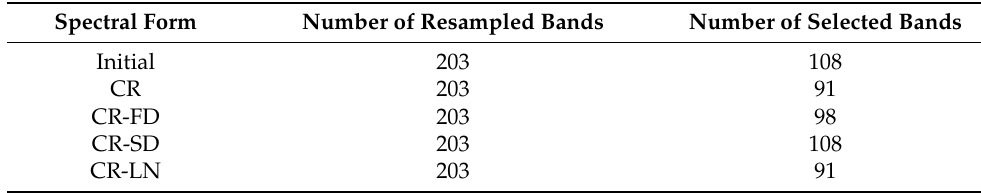
Table 2. Statistical table of bands selected using GA.